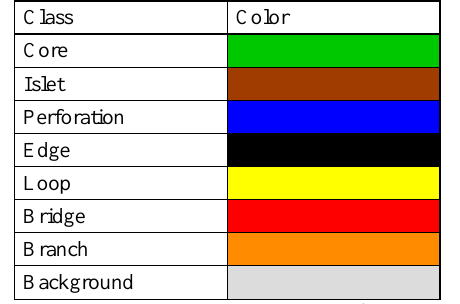
Table 2. Resulting class names and colors (Voght, 2007)